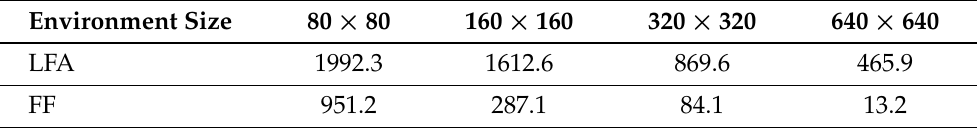
Figure 3. Simulation results: ( a ) results of Scenario 1, ( b ) results of Scenario 2, ( c ) results of Scenario 3, ( d ) results of Scenario 4. Table 3. Targets found when increasing the environment size— Scenario 2 .